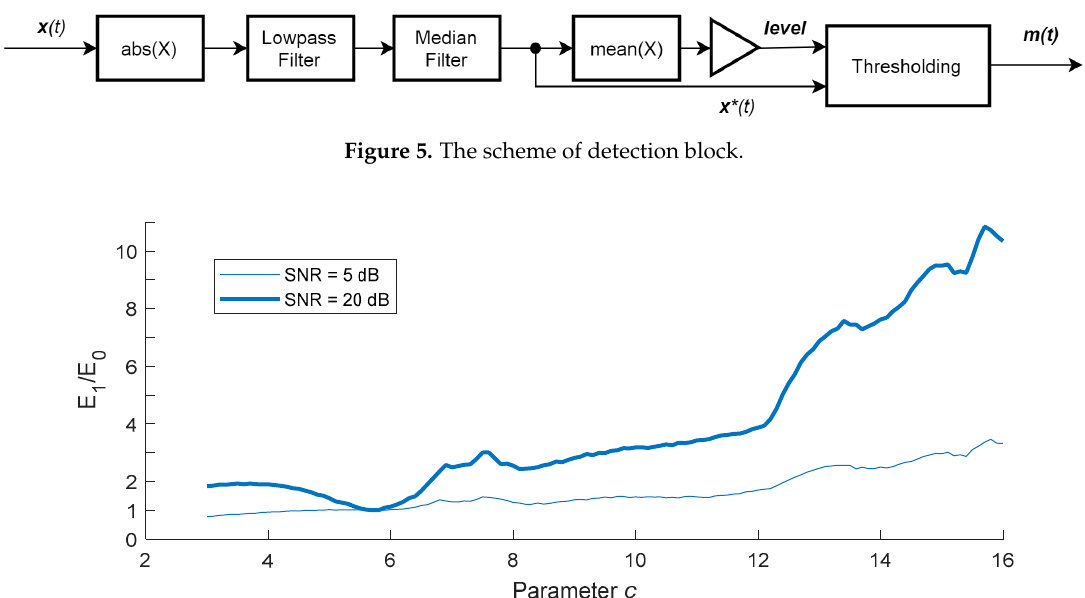
Figure 5. The scheme of detection block. Figure 6. RMS ratios for synchronization error in case of logical 1 ( E 1 ) and logical 0 ( E 0 ) transmission depending on parameter c value. Levels equal and lower than E 1 / E 0 = 1 corresponds to the case of total message loss.